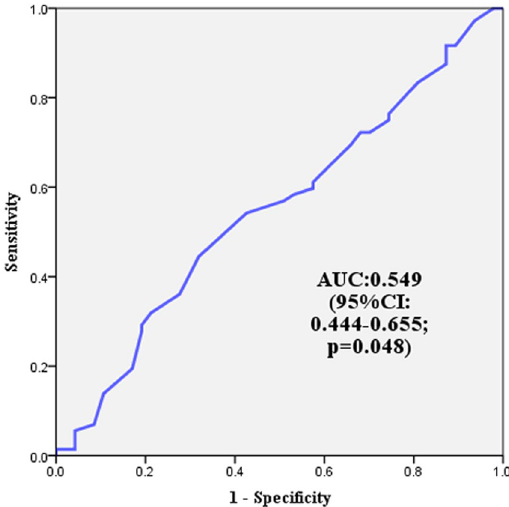
Figure 3. A representative Receiver operating characteristics (ROC) curve. The area under the curve (AUC) was used to calculate the slope of serum LDH status in the